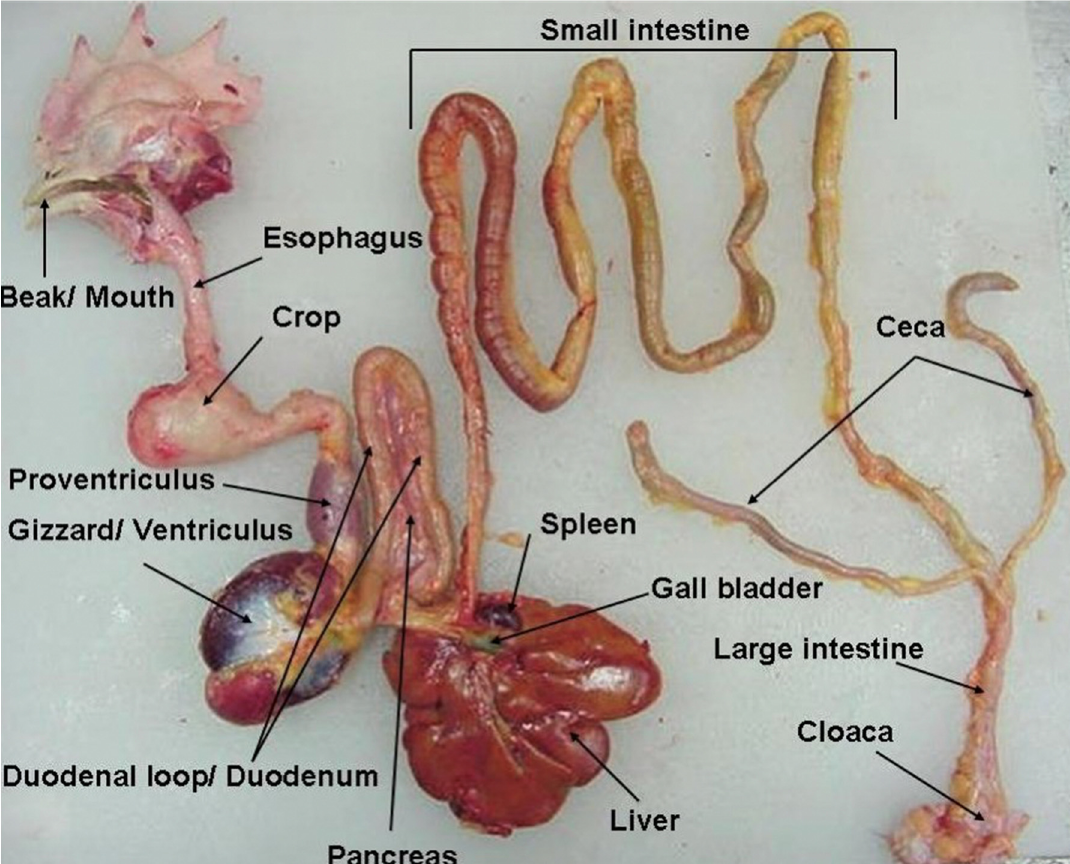
Figure 2. Diagrammatic representation of different parts of the digestive organs of a typical chicken. (adapted from [44]).